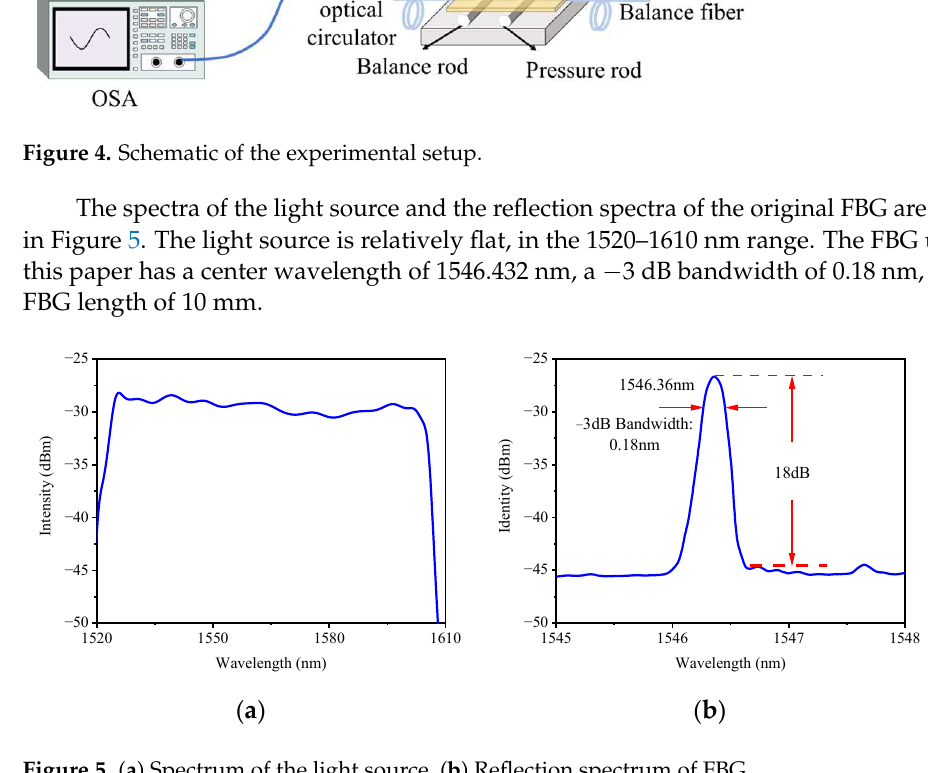
Figure 5. ( a ) Spectrum of the light source, ( b ) Reflection spectrum of